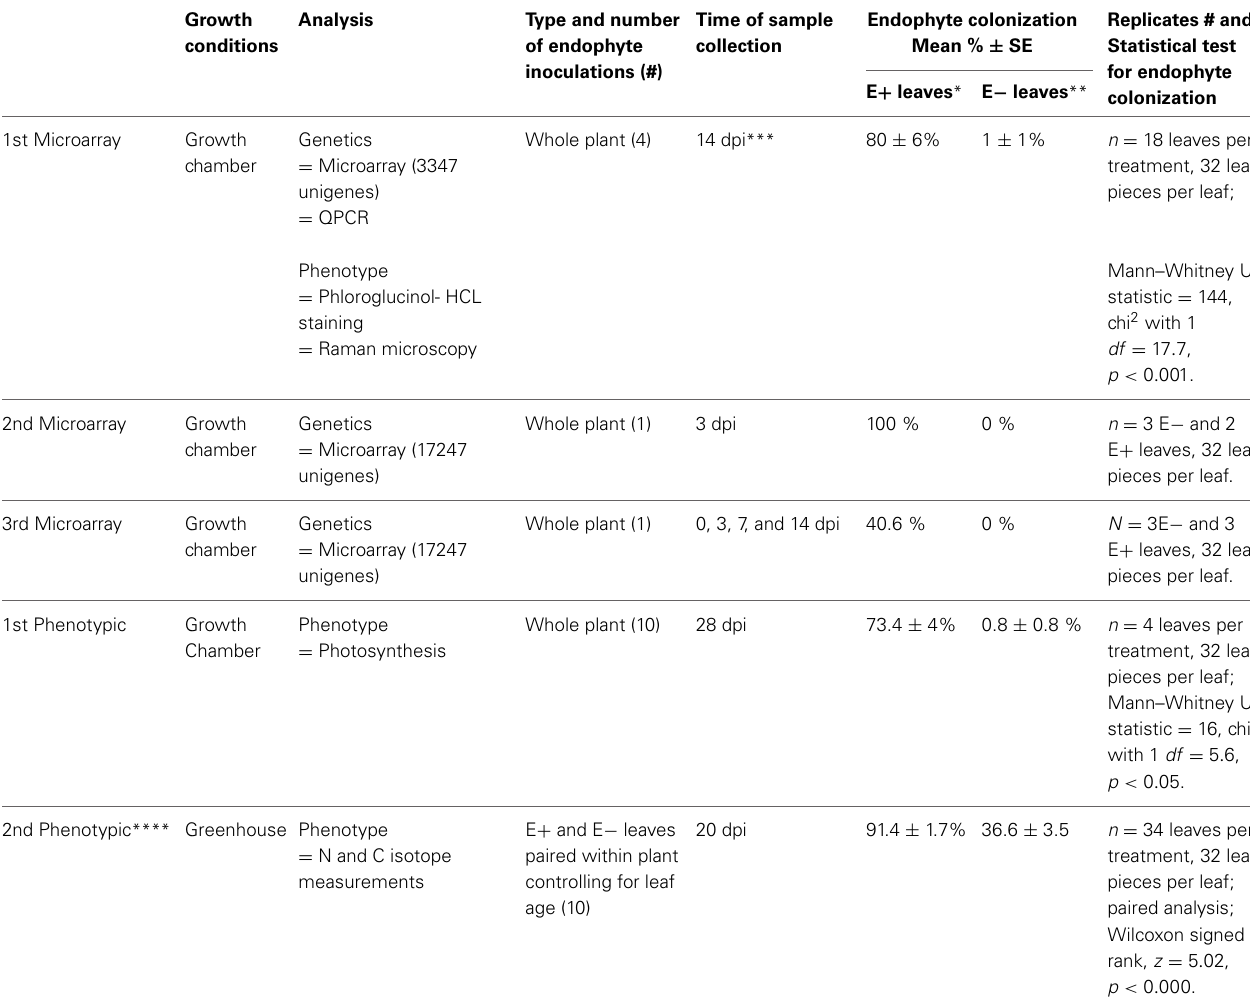
Table 1 | Summary of